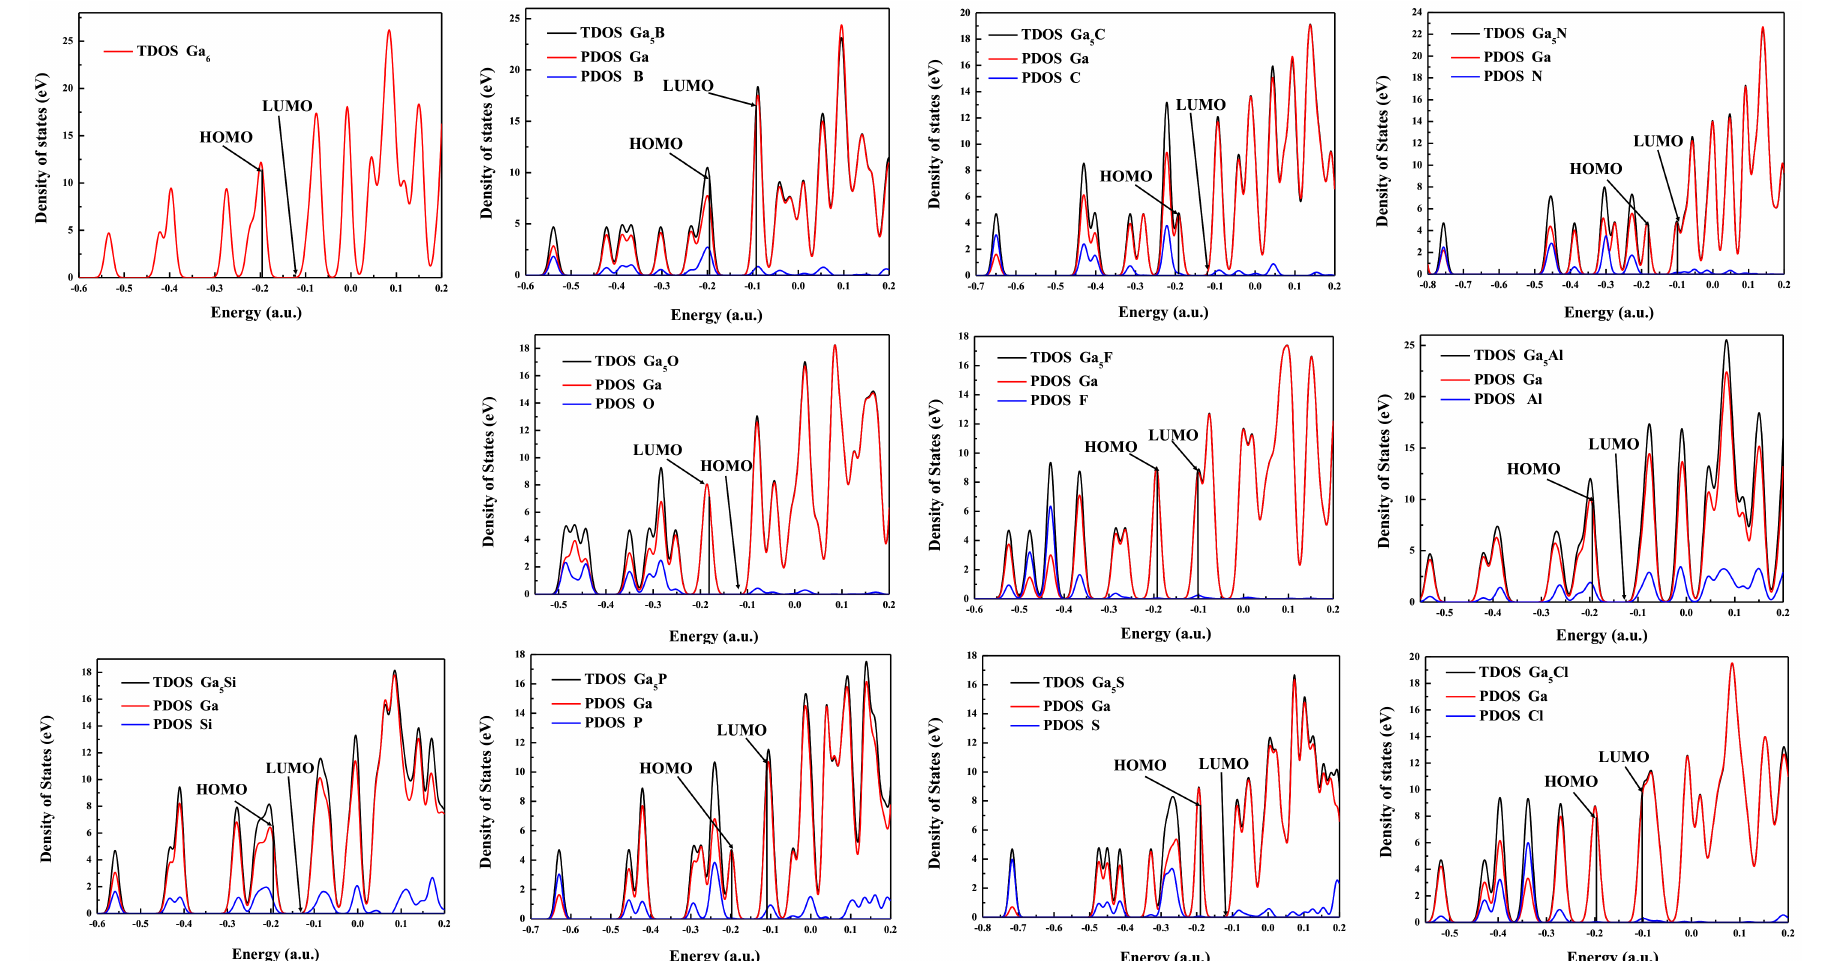
Figure 4. Calculated total densities of states (TDOS) and partial densities of states (PDOS) of Ga 5 X (X = B, C, N, O, F, Al, Si, P, S, Cl)